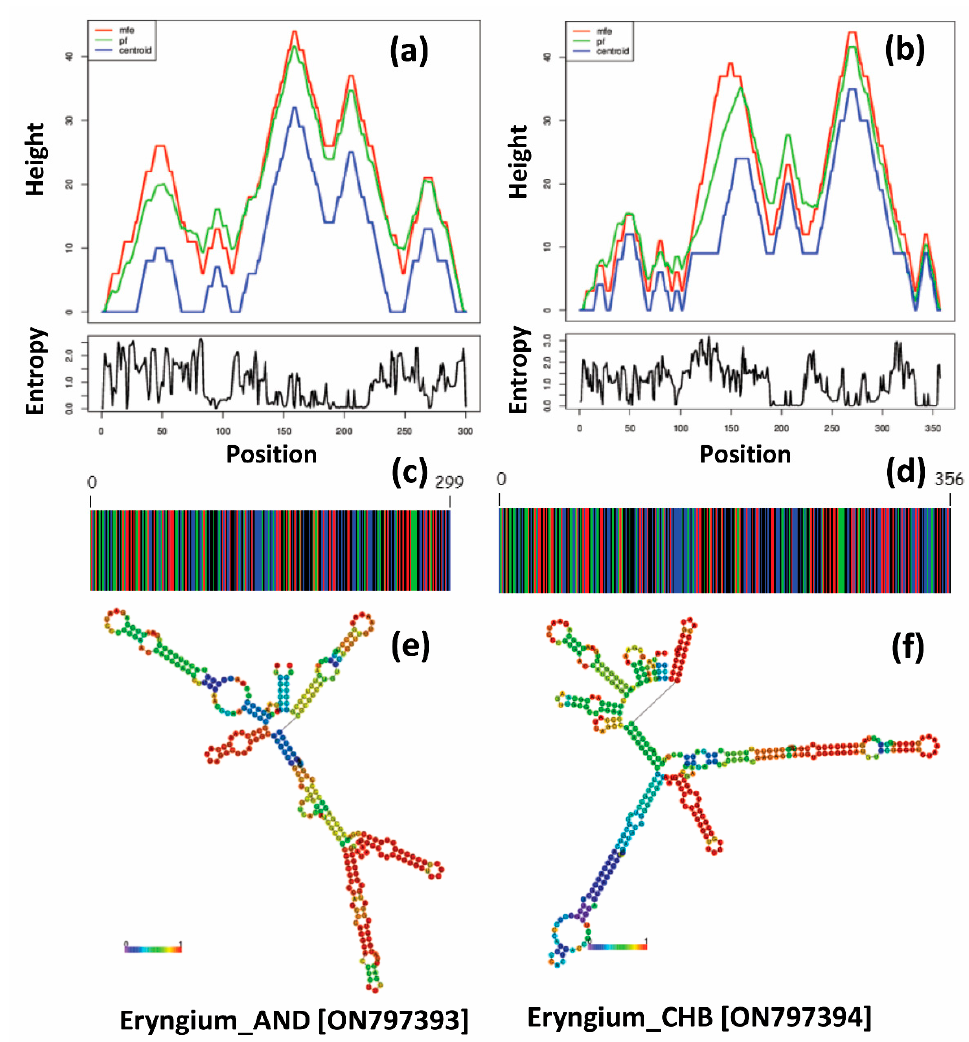
Figure 4. The variations observed in the predicted minimum free energy (MFE) (a, b), DNA bar- codes (c, d), and secondary structures of ITS2 region (consensus structure; e, f) for the Eryngium genotypes. Table 3. Sequence characteristics, and the intraspecific and interspecific genetic divergence of can- didate